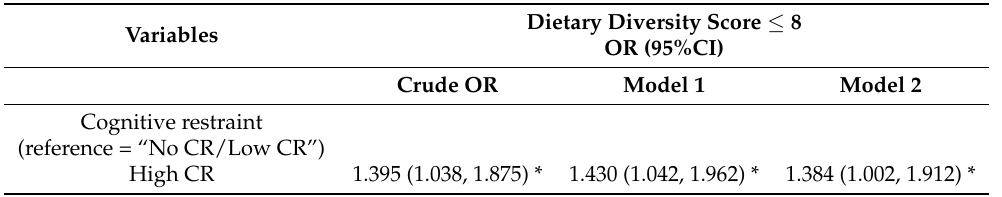
Table 5. Logistic regression analysis of the related factors of dietary diversity scores (DDS) among